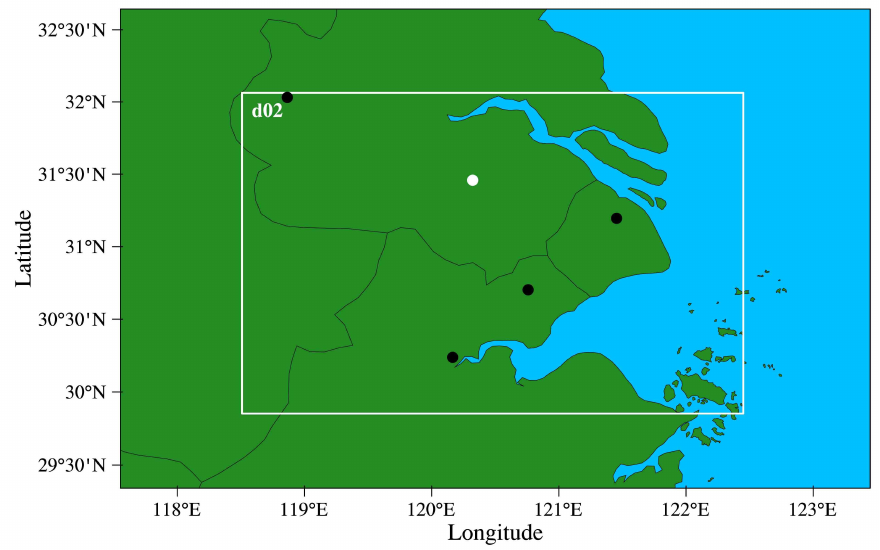
Figure 2. The nested grids of the simulated areas in WRF